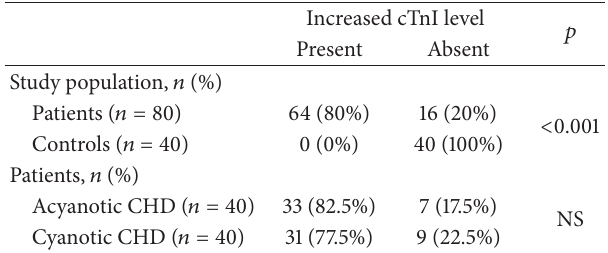
Table 3: Incidence of increased cTnI level in study